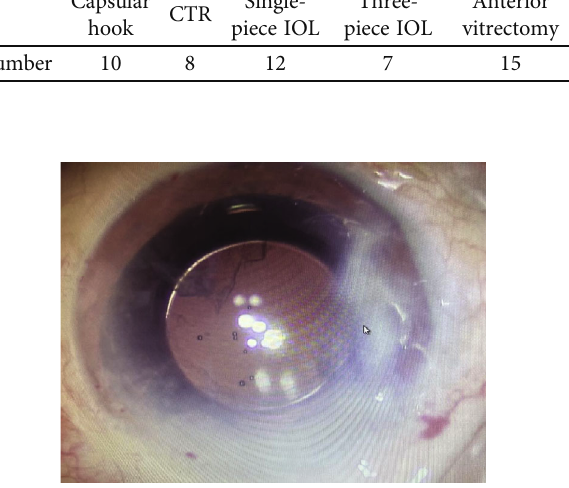
Figure 8: The intraocular lens was centered and the pupil was round.